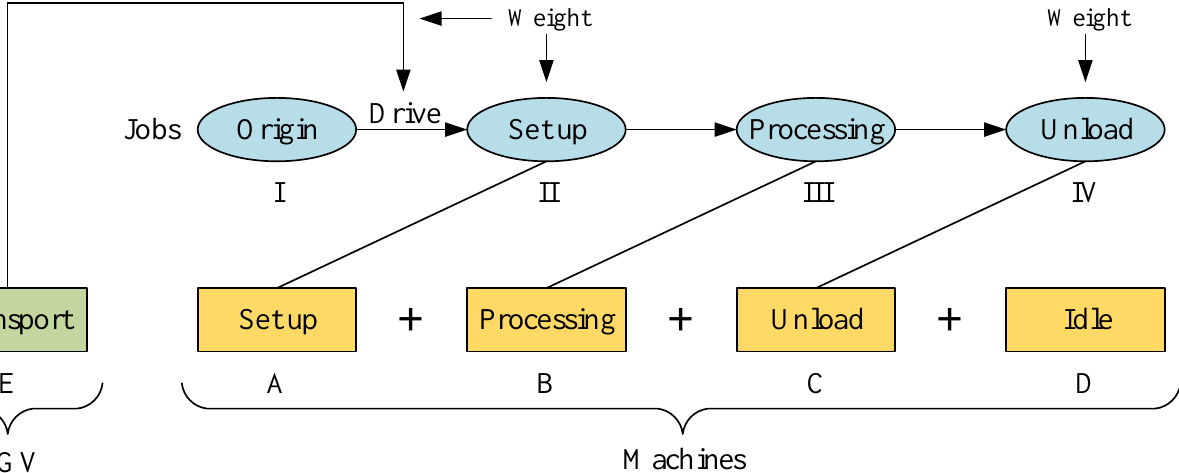
Figure 1. Main structure of our FJSP